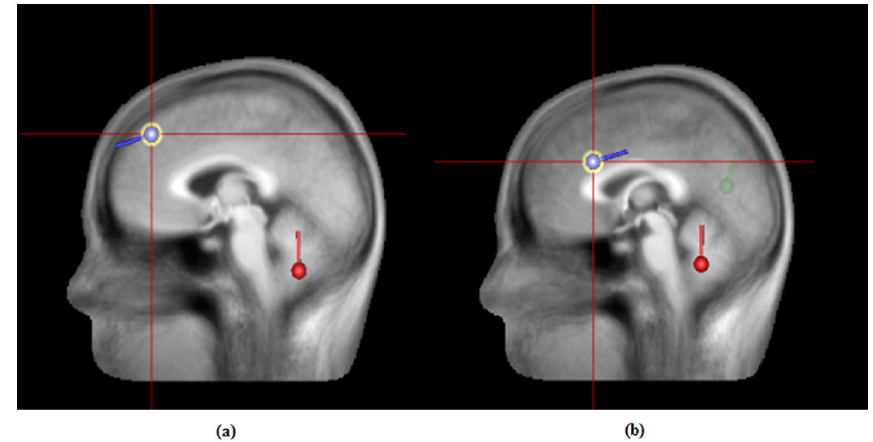
Figure 6. Dipole source localization images of parental faces versus unfamiliar faces for P300 latency. The main different brain regions in response to the father’s and mother’s faces were the right medial frontal gyrus (Figure 6a) and the left anterior cingulate gyrus (Figure 6b); blue spots signify the different regions. Activation of the both of the parental faces was also located in the regions of the cerebellar tonsil (red spot) and the precuneus (green spot). doi: